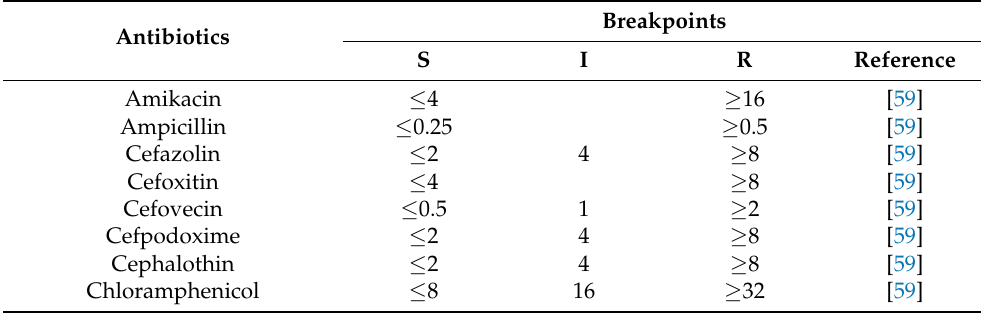
Table 6. The MIC interpretive breakpoints for the antibiotics used for the Staphylococcus spp. tested in this